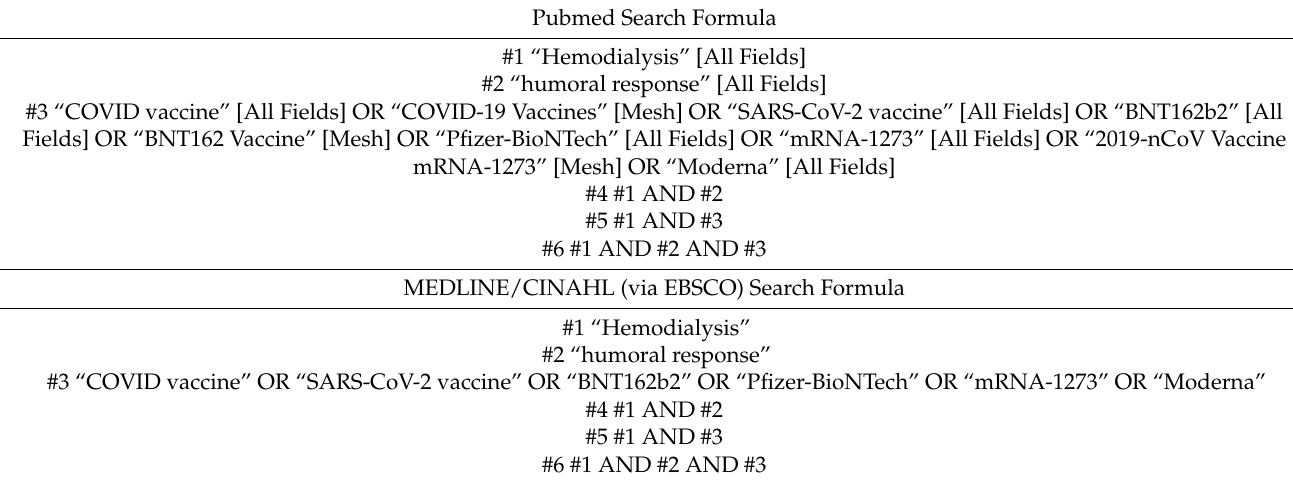
Table 1. Database formulas using literature